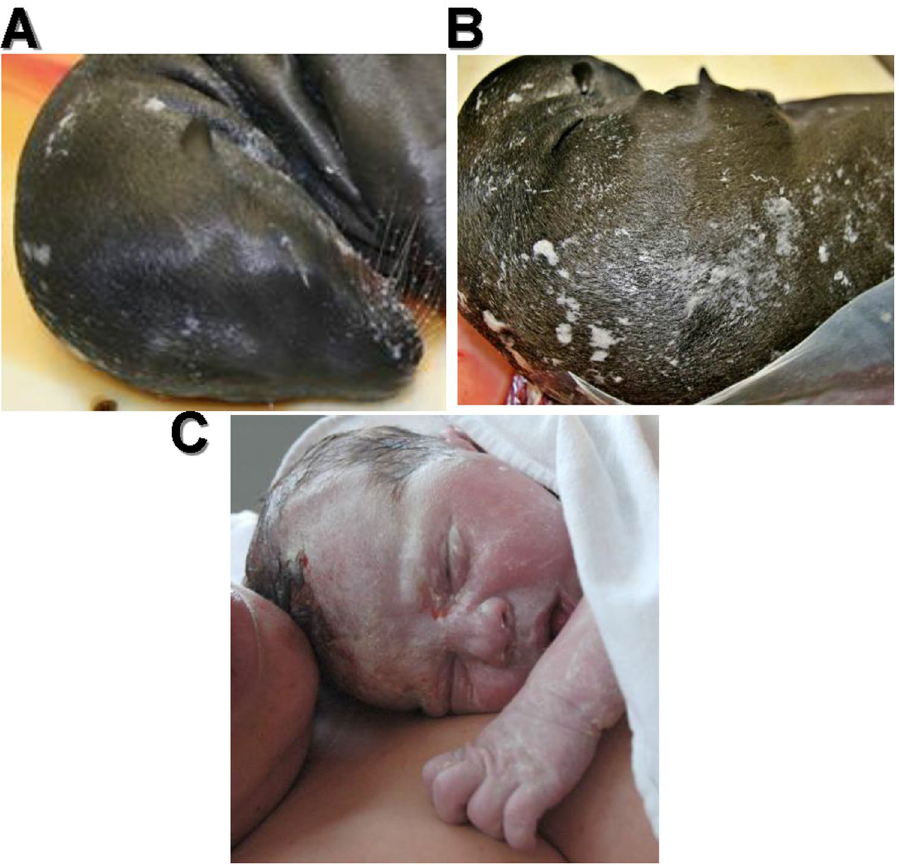
Figure 1. Vernix caseosa visible on a late-term California sea lion fetus and a human newborn. ( A ) The sea lion has white debris evident on the whiskers, eyebrows, head, and neck, and ( B ) along the back. ( C ) A human newborn seconds old, with vernix caseosa on most of the